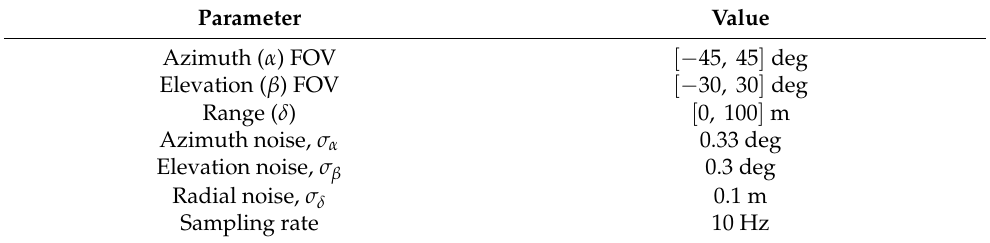
Table 4. LiDAR sensor specifications.